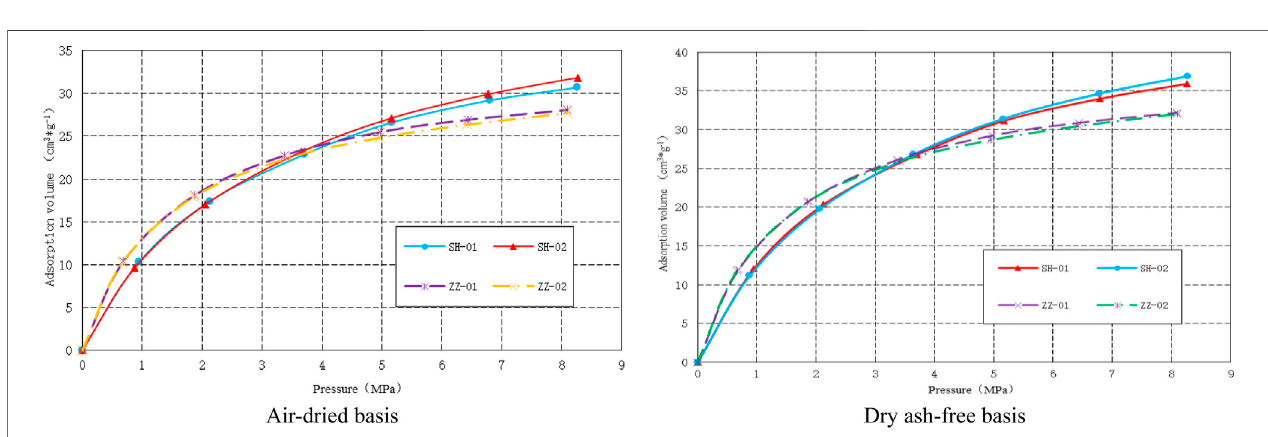
FIGURE 7 | Isothermal adsorption curves of NO.3 coal